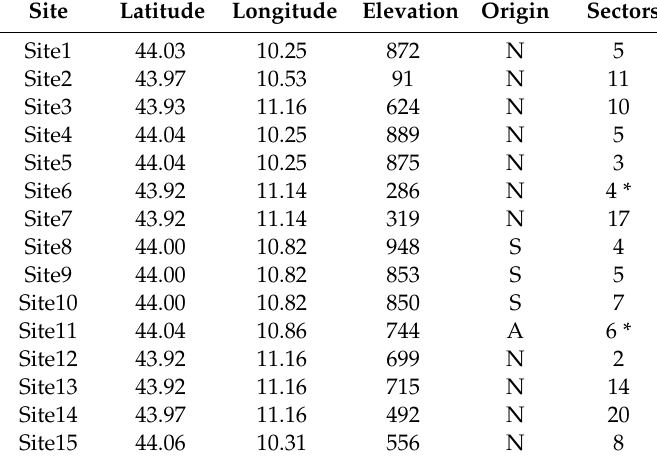
Table 1. List of the surveyed subterranean environments. For each Site we provide: Latitude (N), Longitude (E), Elevation (m a.s.l.), Origin (N = natural; S = semi-natural; and A = artificial), and the number of surveyed Sectors. Latitude and longitude are shown with reduced precision to increase species protection [51]. Site Latitude